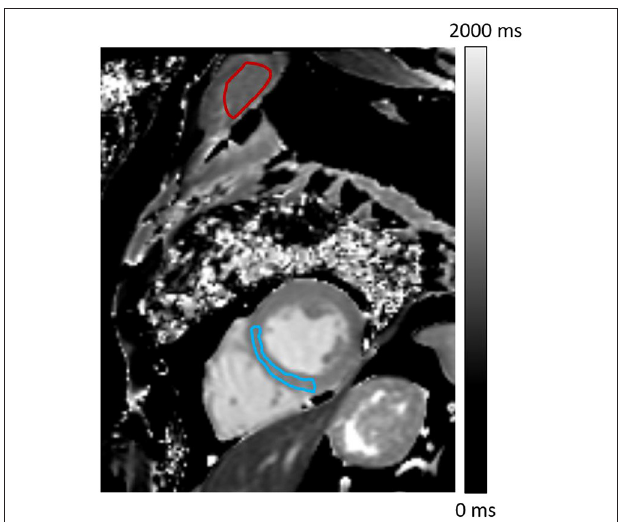
FIGURE 1 | Pre-contrast T1 map showing regions-of-interest (ROIs) drawn to determine ECV and relaxation times on the myocardium (blue) and shoulders skeletal muscle (red).